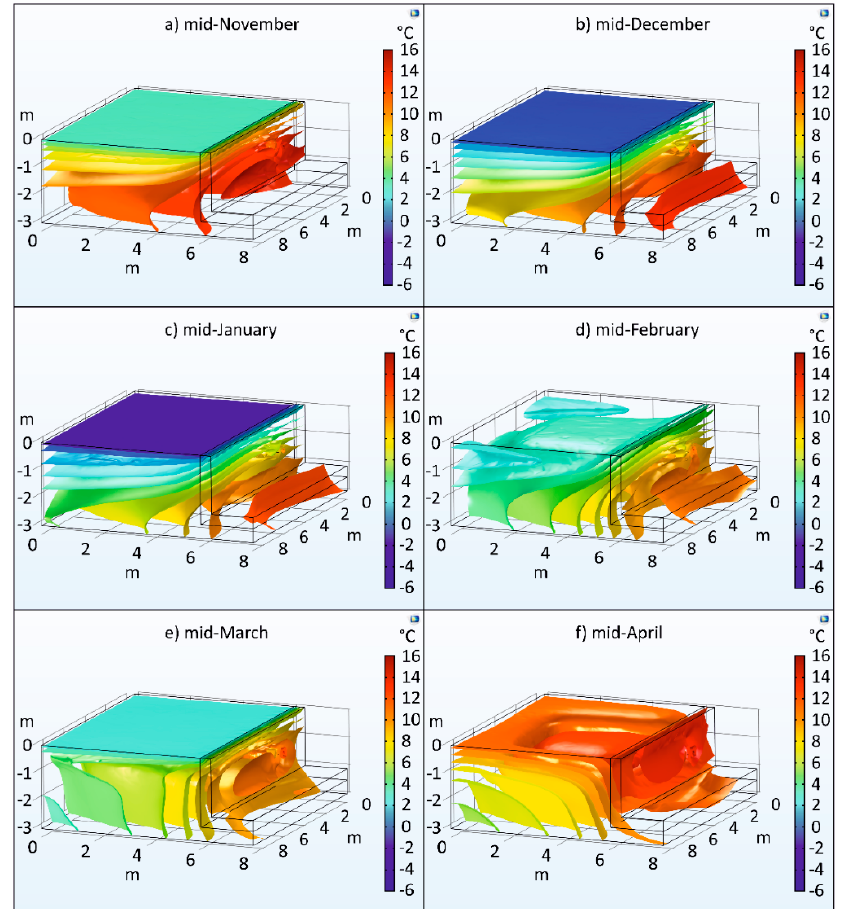
Figure 9. The tri-dimensional temperature isosurfaces for the simulation case 4—HGHE with heated basement and solar thermal panels: ( a ) mid-November; ( b ) mid-December; ( c ) mid-January; ( d ) mid- February; ( e ) mid-March; ( f ) mid-April.